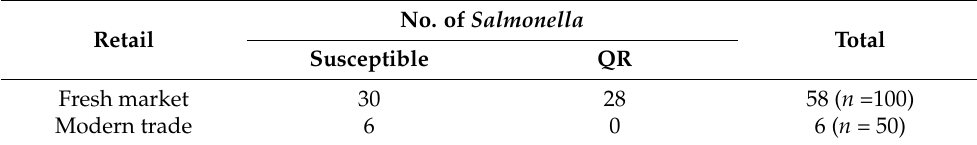
Table 2. P PROB and mean concentration of contaminants in the pork samples. P PROB (%) Mean Concentration ± SD (log cfu/g) Retail